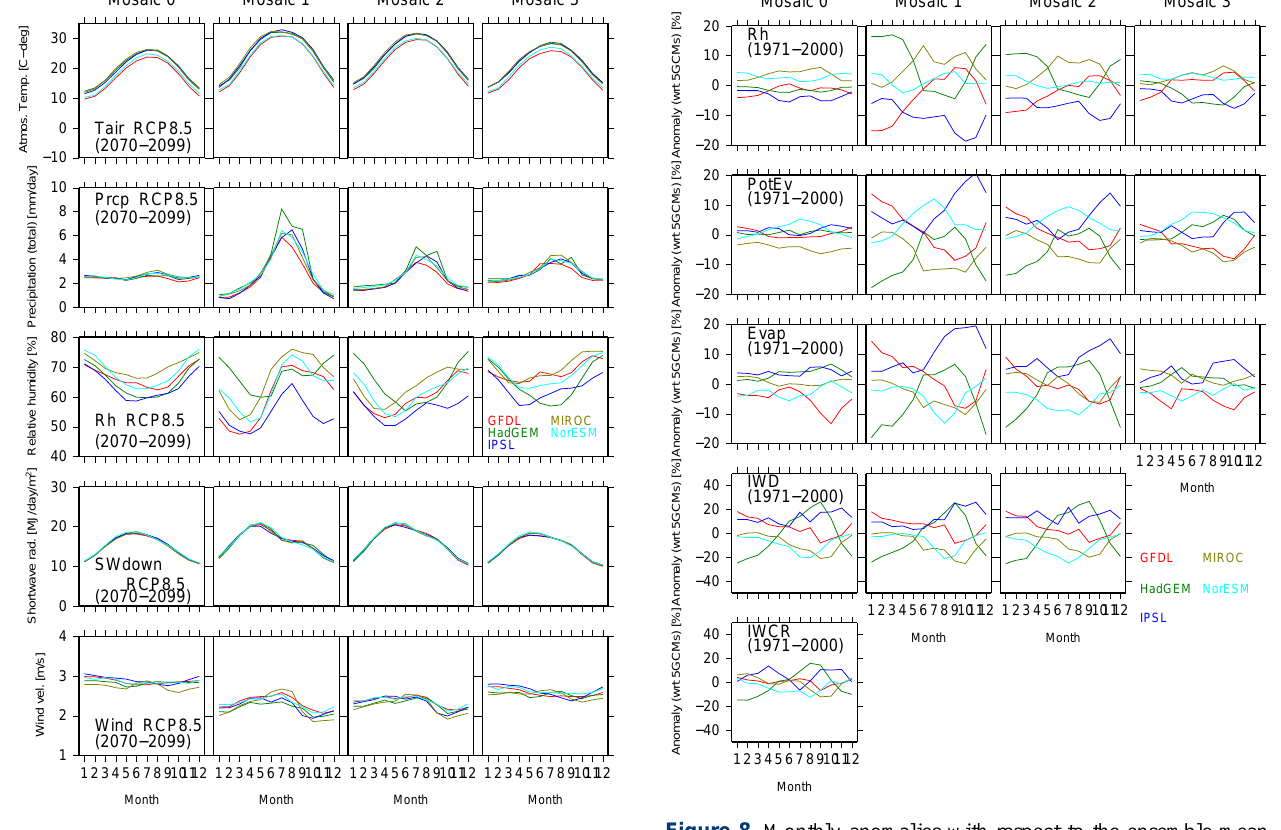
Figure 7. Monthly profiles of meteorological elements used in this study for 2070–2099 under RCP8.5. The results are aggregated over each type of land use, identified by the mosaic number. Profiles of the five GCMs are indicated in different colors: (red) GFDL, (green) HadGEM, (blue) IPSL, (dark yellow) MIROC and (light blue) NorESM.